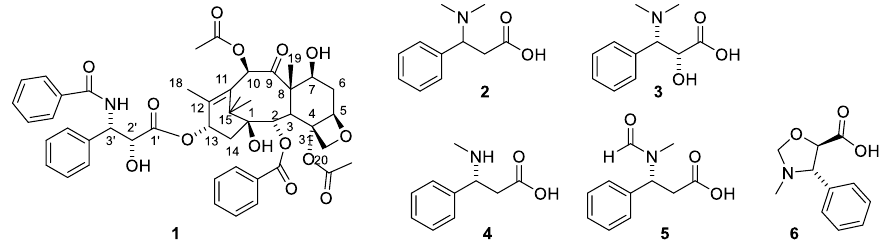
Figure 1. Paclitaxel ( 1 ) and phenylisoserine ( 2 – 6 ) analogues esterified with diterpenes.